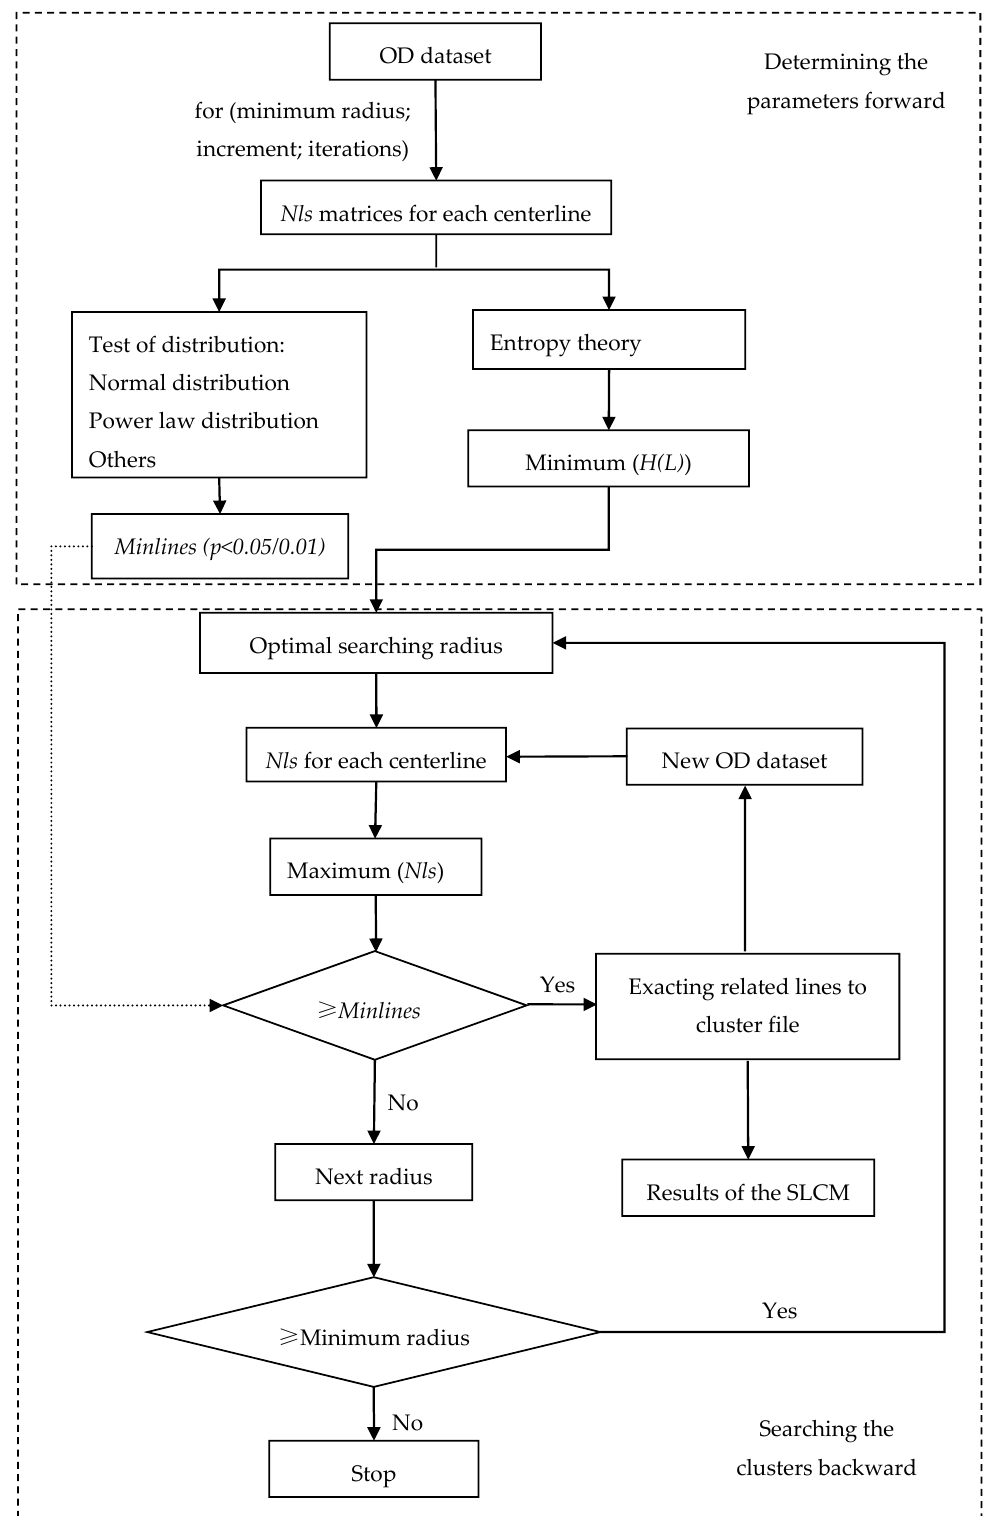
Figure 7. The overall process of the SLCM with flexible radius.